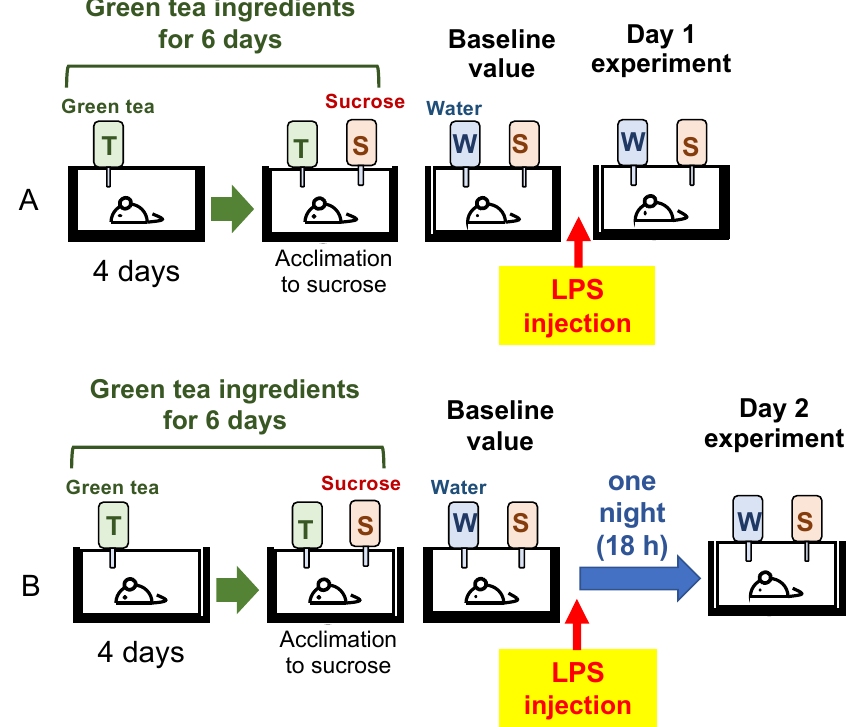
Figure 1. Mice ingested green tea ingredients for 6 days, and a sucrose preference test was performed before and after injection of LPS in ( A ) 1-day and ( B ) 2-day experiment. LPS was dissolved in normal saline (0.2 mg/mL). Mice were intraperitonially injected with LPS (0.5 mg/kg). Bottle labels: T, green tea ingredients; S, 1% ( w / v ) sucrose; W, water.